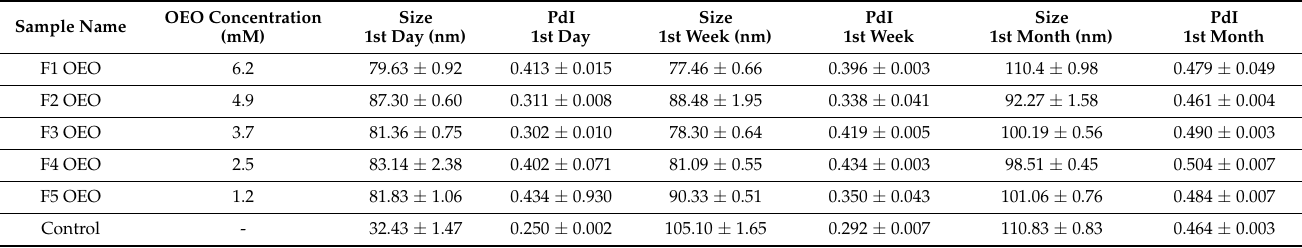
Table 1. Average particle size and PdI of OEO nanoliposomes and control sample at different concentrations after 1 day, 1 week, and 1 month of storage at 4 ◦